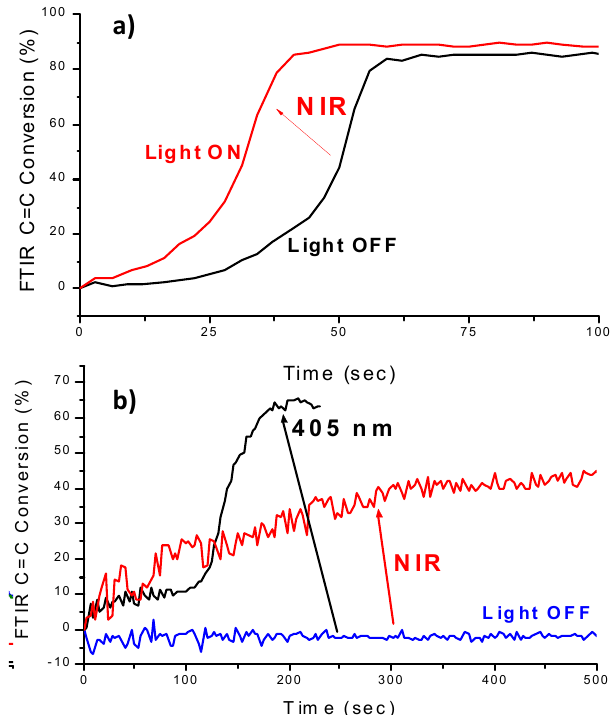
Figure 30. Final monomer conversions determined by real-time Fourier Transform Infrared (RT-FTIR) measurements during the redox and redox photoactivated FRP under air. ( a ) With the two-component Cu-37 / 2-dppba / Iod (0.7% / 1.5% / 1.5% w / w / w ) upon irradiation with a LED@785 nm (400 mW / cm 2 ) with 0.085 wt% tempol in the resin. ( b ) With the two-component Cu-35 / 2-dppba / Iod (0.7% / 1.5% / 1.5% w / w / w ) upon irradiation with a LED@785 nm (400 mW / cm 2 ) or LED@405 nm (110 mW / cm 2 ) with 0.117 wt% tempol in the resin. Reproduced with permission from the authors of [67]. Copyright 2018 The Royal Society of Chemistry. Catalysts 2020 , 10 , x FOR PEER REVIEW